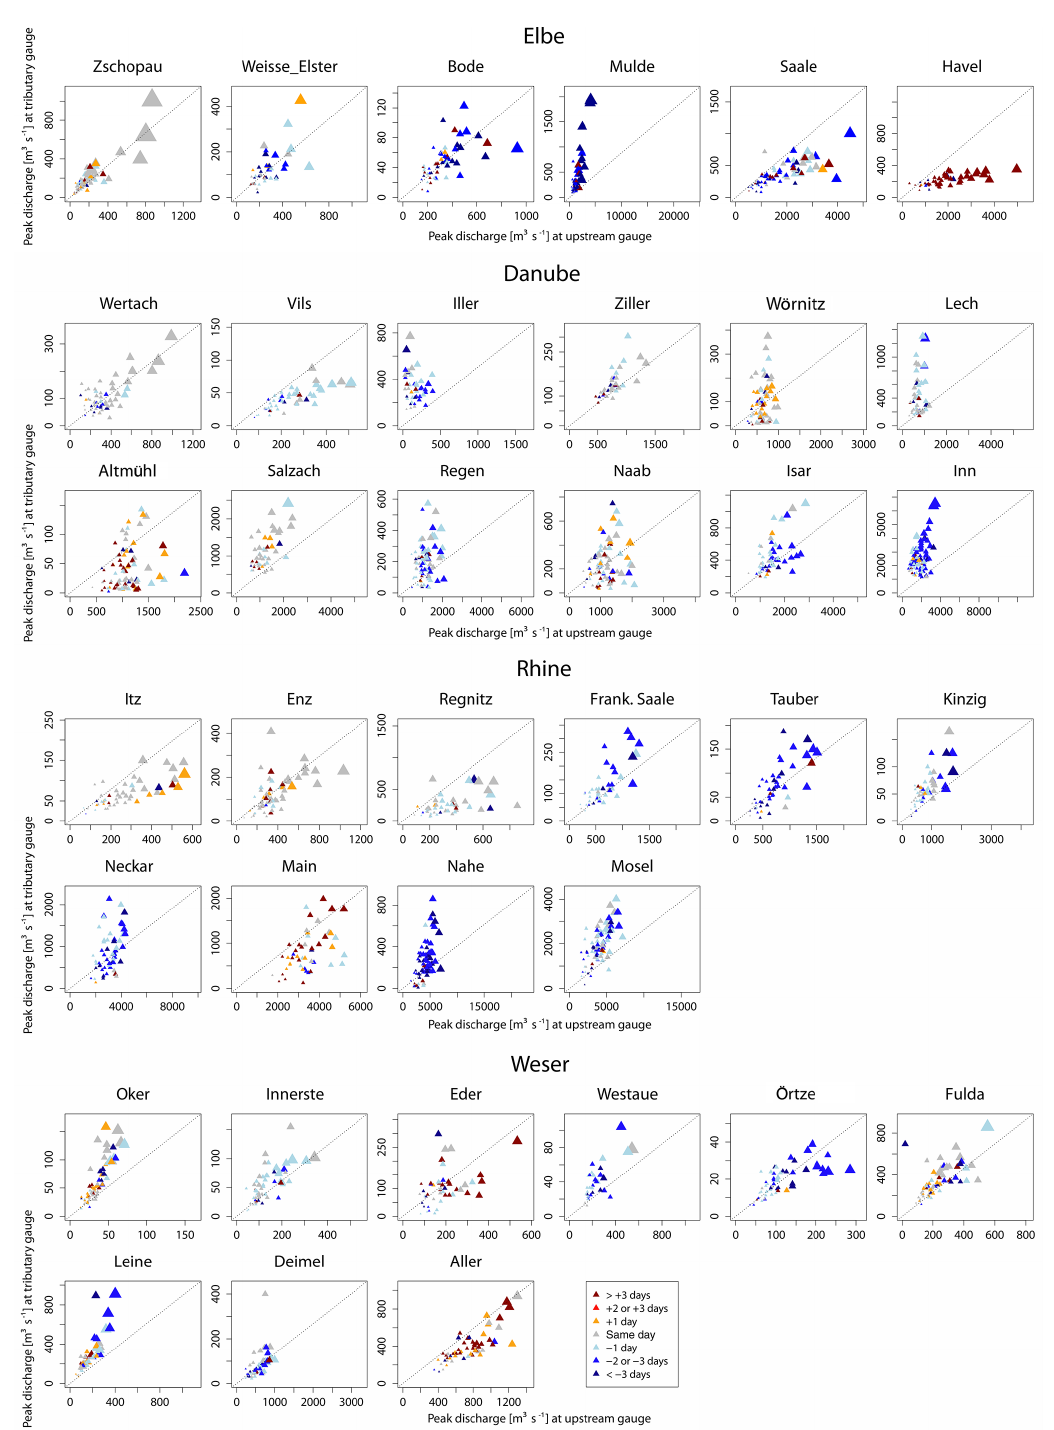
Figure 6. The relationship of peak discharge between the upstream and tributary gauges for all selected events. The size of the triangles shows the downstream peak magnitude, normalised by the mean peak discharge: the larger the triangle, the larger the flood magnitude compared with the mean annual flood. The diagonal line delineates the same specific discharge at tributary and upstream gauges. Triangles above (below) the line represent a higher (lower) specific discharge at the tributary gauge compared with the upstream gauge. The colours express the time lag between the tributary and upstream peak: blue shows that the upstream peak occurs later, and red shows that the tributary peak occurs